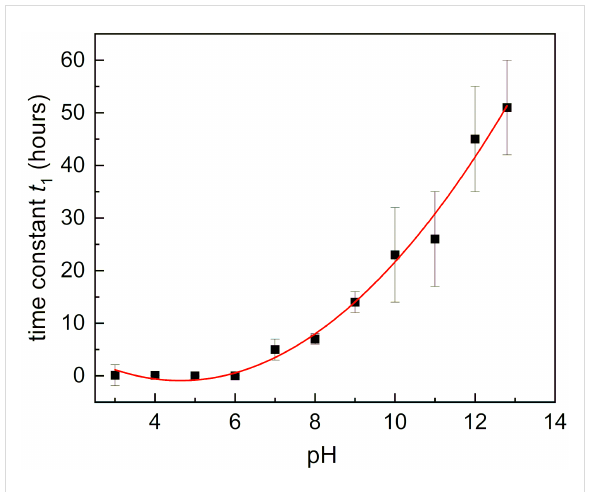
Figure 4: pH behavior of the time constant t 1 of the fast component in the time evolution of the NMR signal of the imine group of the com- pound 3d . Error bars correspond to the regression error; red line corre- sponds to the polynomial fit of the experimental